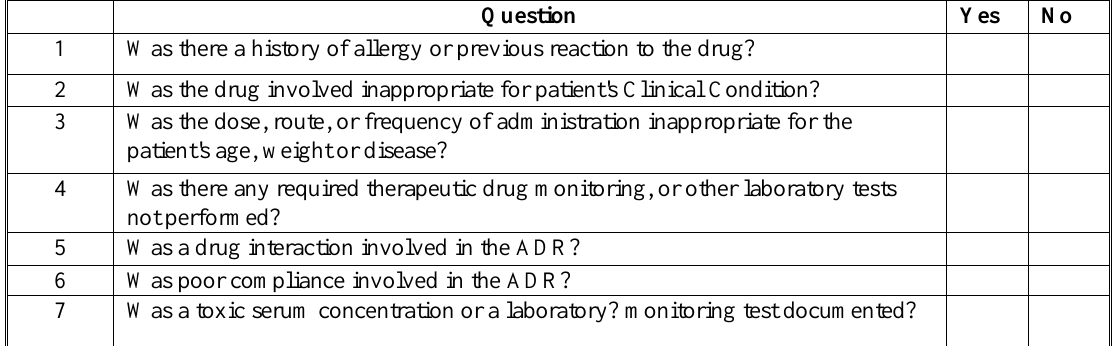
Table 3 ． Schumock and Thornton preventability assessment criteria